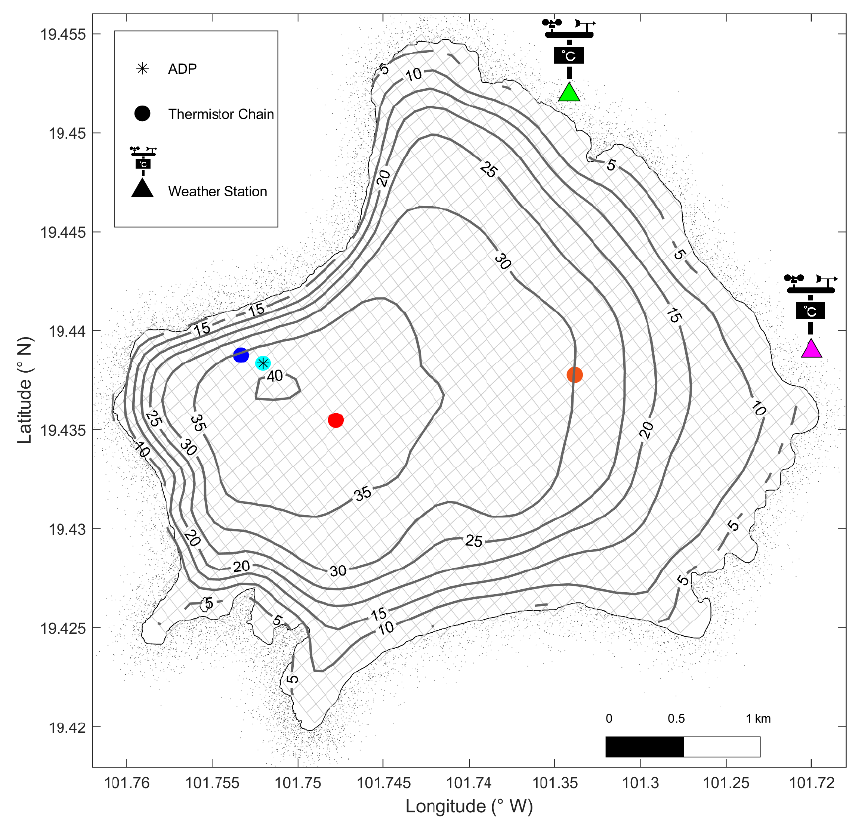
Figure 2. Bathymetry of Lake Zirahuén in meters. Legends and colors indicate field campaigns of measurements conducted in 2018, from February to November; involving the use of thermistor chains, weather stations, and an acoustic current meter profiler (ADP), see Table 1. It is shown also the horizontal grid used in the numerical model of lake Zirahu é n. Table 1. Dates and instruments used in each campaign.